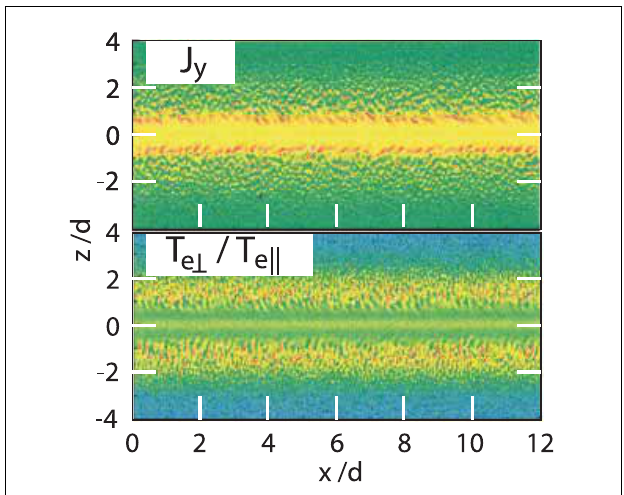
FIGURE 11 | Bifurcation of a thin current layer caused by the lower-hybrid-drift instability (simulation data taken from Daughton et al. [69] with permission from American Physical Society). Top: Sheet current strength color coded (highest intensity red, lowest green). The initial current was concentrated at z / d = 0. After evolution of the lower-hybrid drift instability it has split into two current layers separated by about one initial layer half-width d indicating lower-hybri-ddrift instability mediated current bifurcation. The bifurcated current is structured in x by the lower-hybrid wavelength. Bottom: Electron temperature anisotropy T e ⊥ / T e (cid:13) caused in current bifurcation. The anisotropy is positive and concentrated mainly on the bifurcated current. A weak anisotropy is attributed to the original current center. Lengths are measured in halfwidths d